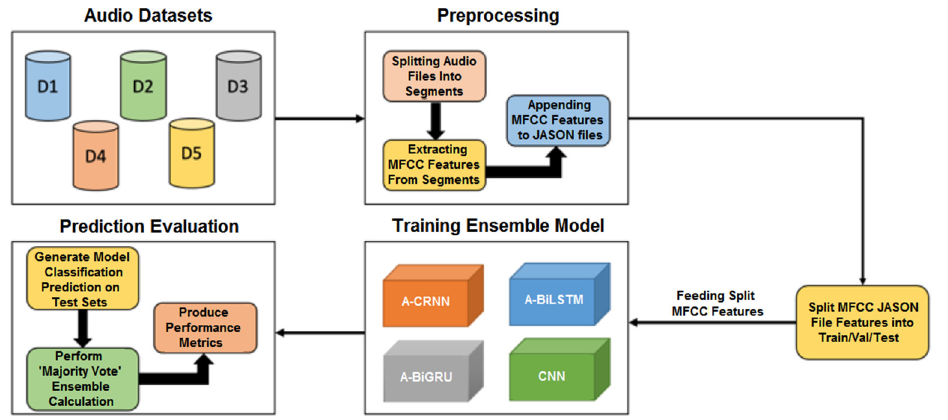
Figure 1. The proposed ensemble model comprising four base networks for diverse lung abnormality and COVID-19 diagnosis .